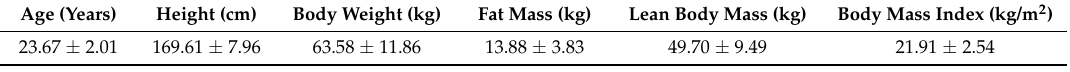
Table 5. Characteristics of the subjects included in D-allulose gastrointestinal tolerance test.